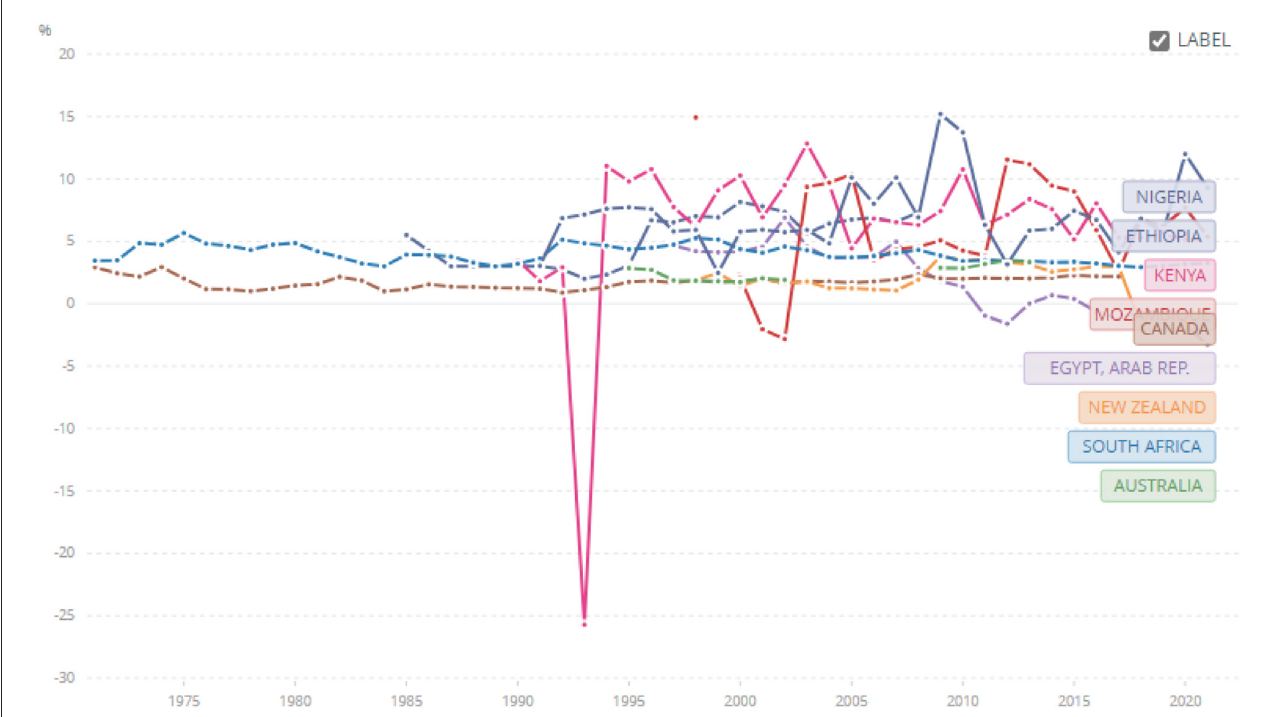
FIGURE4 Risk premium on lending (lending rate minus Treasury Bill rate, %) from 1971 to 2021 for Australia, Botswana, Ghana, Ethiopia, Kenya, China, Egypt, India, Mozambique, Canada, New Zealand, Nigeria, and South Africa. Source: World Bank Data - https://data.worldbank.org/indicator/FR.INR.RISK?end=2021&